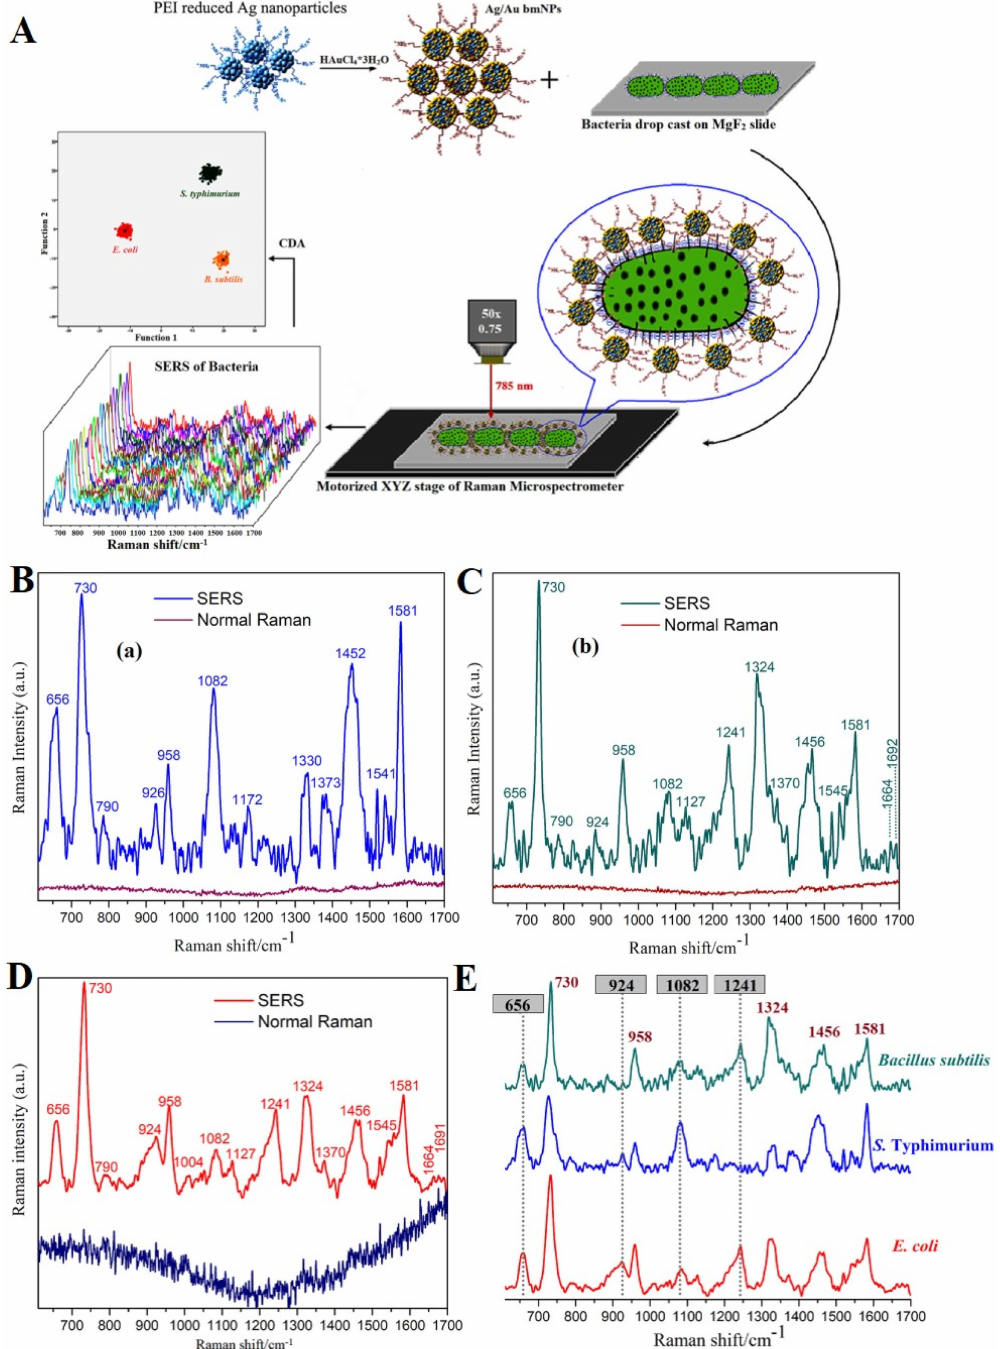
Figure 4. ( A ) A schematic diagram of SERS-based detection of bacteria using label-free Ag/Au bimetallic nanoparticles and canonical discriminant analysis-based classification; ( B ) SERS spectrum of Salmonella typhimurium; ( C ) SERS spectrum of Bacillus subtilis; ( D ) SERS spectrum of Escherichia coli and ( E ) comparison of SERS spectra of three types of bacteria with marked spectral